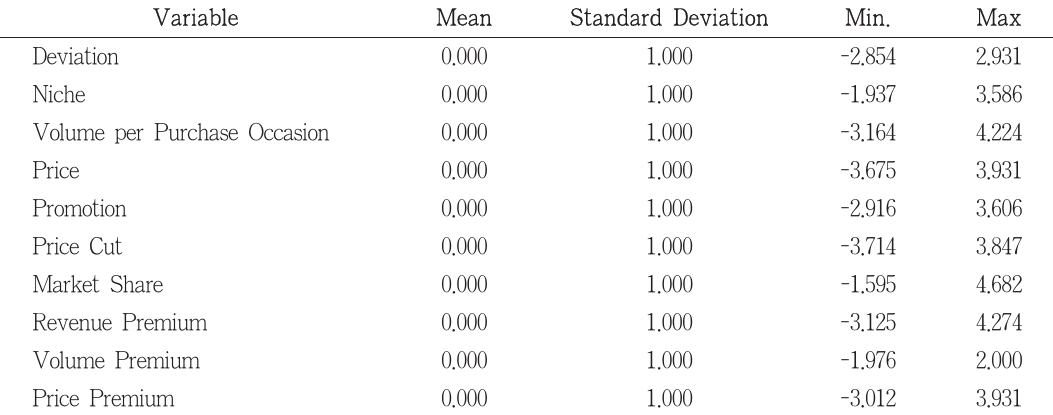
<Table 1> Univariate Statistics